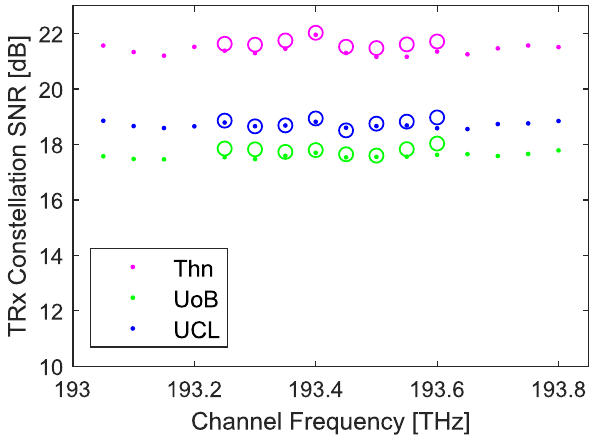
Figure 6. Channel performance. UoC measured optical channel performance for each channel, for the three loop backs and for 8 or 16 channels, 32 GBd PM-QPSK. Dots refer to 16 channel measurements, circles to 8 ≈ channel measurements 21